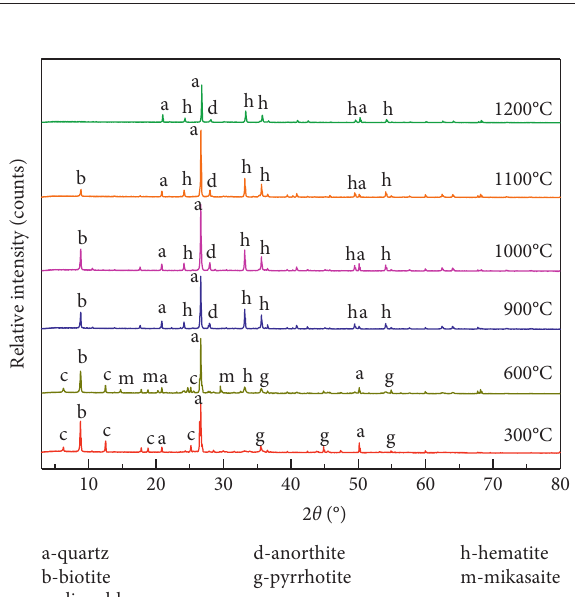
Figure 4: The XRD patterns of the roasted slag at varying temperature.